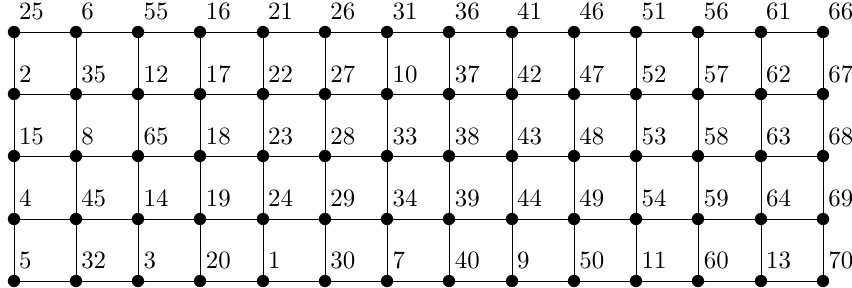
Figure 2: Prime labeling on P